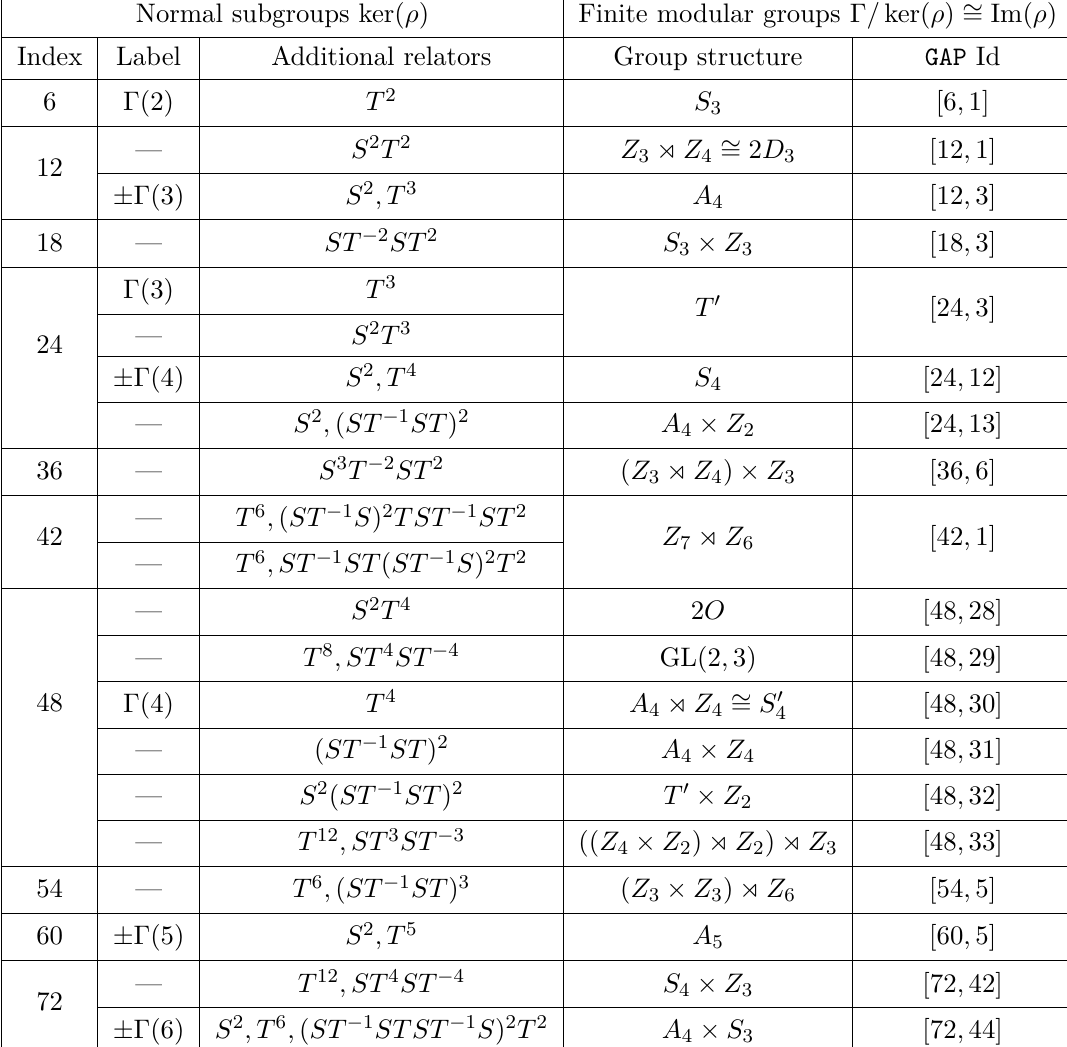
Table 2 . The normal subgroups of SL(2 , Z ) with index less than 78 and the corresponding finite modular groups. It is defined ± Γ( N ) = {± γ, γ ∈ Γ( N ) } . Note that 2 D 3 is the binary dihedral group of order 12 and 2 O is the binary octahedral group which is the Schur cover of permutation group S 4 of type “—”. Additional relators are some elements of ker( ρ ) , the quotient group Γ / ker( ρ ) is produced when the relations “Additional relators = 1 ” together with S 4 = ( ST ) 3 = 1 and S 2 T = TS 2 in eq. (2.2) are